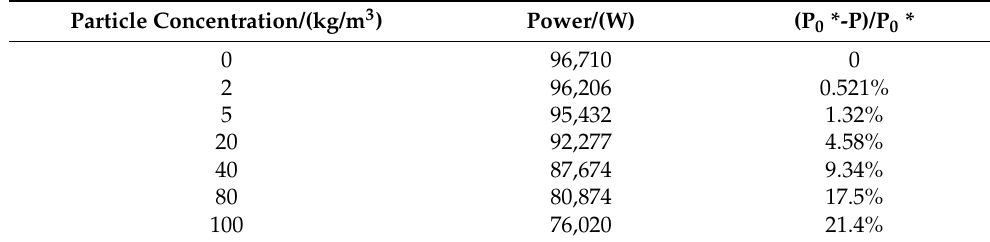
Figure 21. The variation curves of lift and drag coefficients of airfoil 28 with particle concentration when the particle diameter is 2500 µ m: ( a ) lift coefficient; ( b ) drag coefficient. Table 7. The power of the 120 kW tidal current turbine at different particle concentrations when the particle diameter is 2500 µ